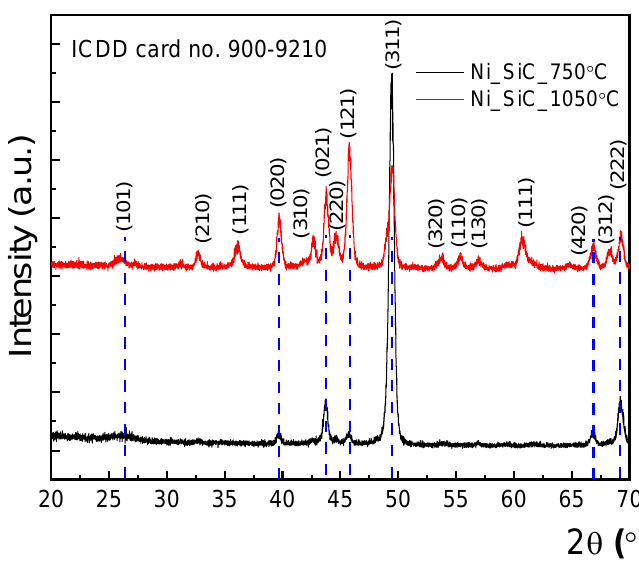
Figure 3. Grazing Incidence X-ray Diffraction (GI-XRD) patterns for the Schottky contact annealed at 750 ◦ (black line) and for the ohmic contact annealed at 1050 ◦ C (red line), respectively. The dashed lines indicate the diffraction peaks position of the Schottky contact besides to the ohmic